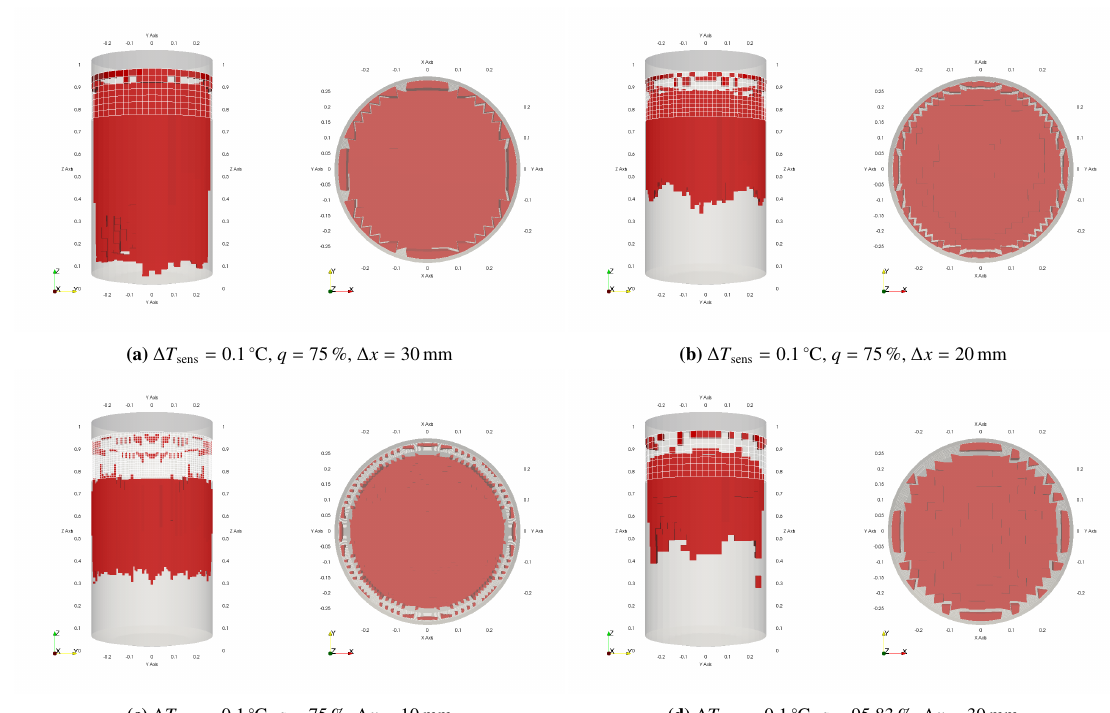
Figure 9. Post-processing output showing suitable sensor locations (red) for the small tank case study assessed for different ∆ x (( a ): 30mm; ( b ): 20mm; ( c ): 10mm) and constant threshold values (( a – c ): ◦ C and q = 75%). ( d ) Effect of changing the percentage of valid measurements q to 95.83% ∆ T sens = 0.1 for ∆ x = 30mm.